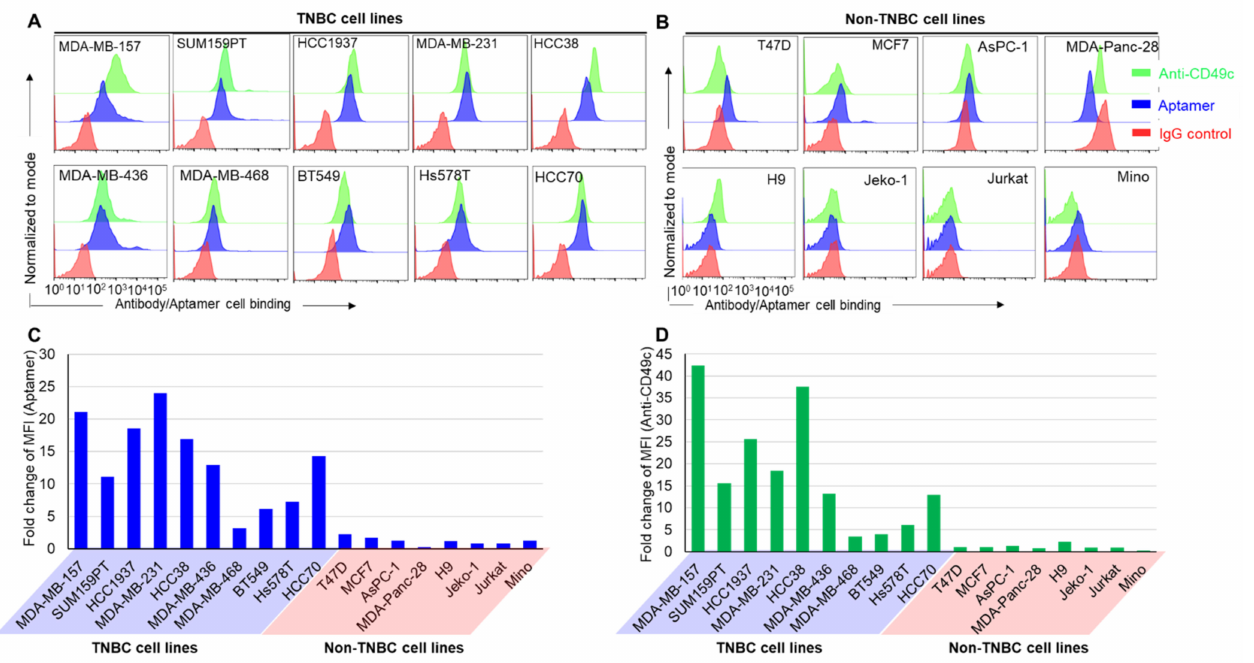
Figure 5. PDGC21T aptamer selectively targets CD49c-expressing TNBC cells. ( A ) Both PDGC21T aptamer and anti-CD49c targeted TNBC cells with high binding capacity but had ( B ) little or no binding to non-TNBC cells. Resultant mean fluorescent intensities of cell binding by aptamer ( C ) and antibody ( D ) were quantified by flow cytometry and graphed for comparison. The final incubation concentration of aptamer was 200